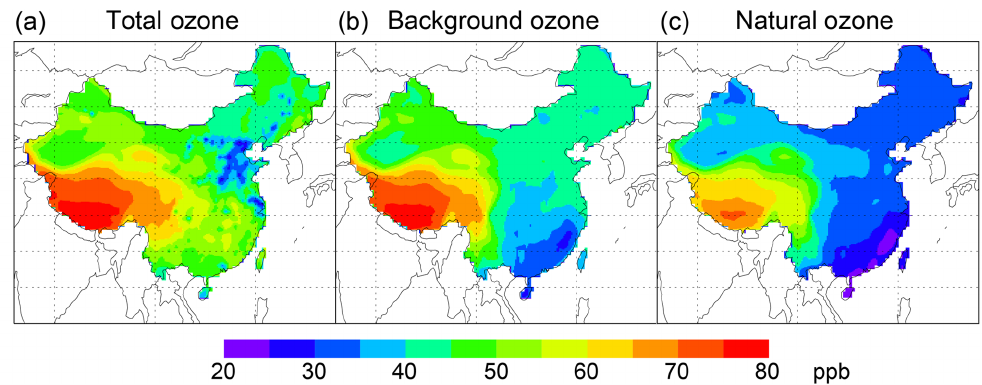
Figure 8. Spatial distribution of springtime daily mean (a) total surface ozone, (b) background ozone, and (c) natural ozone over